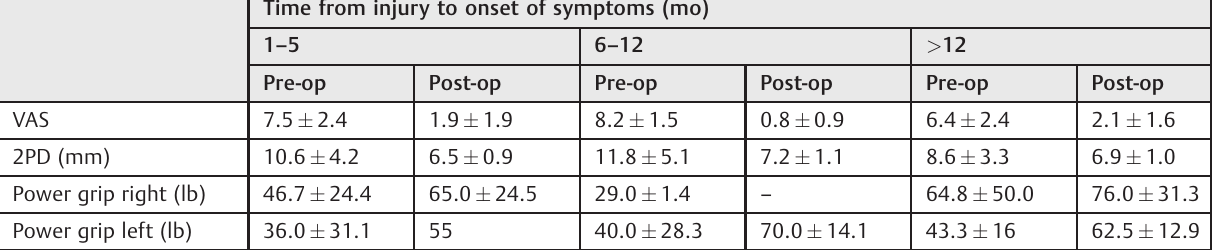
Table 3 Results according to onset of